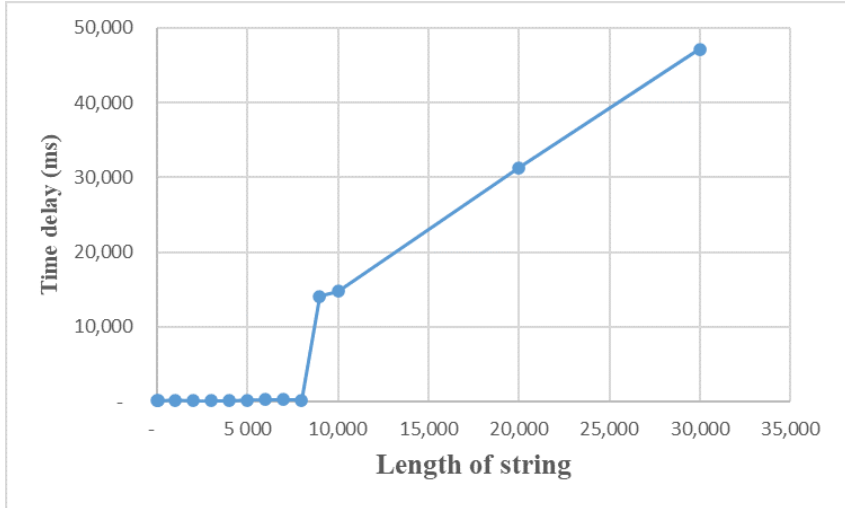
Figure 14. Testing of